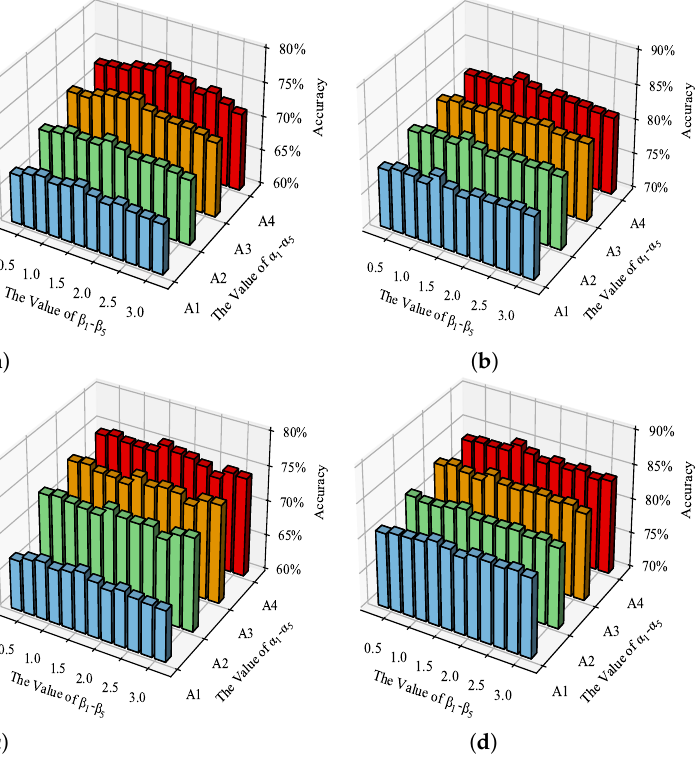
Figure 9. Accuracy with different values of α i and β i on two datasets. ( a , b ) the results on the NWPU- RESISC45 under the condition of 5-way 1-shot and 5-way 5-shot, respectively. ( c , d ) the results on the WHU-RS19 under the condition of 5-way 1-shot and 5-way 5-shot,